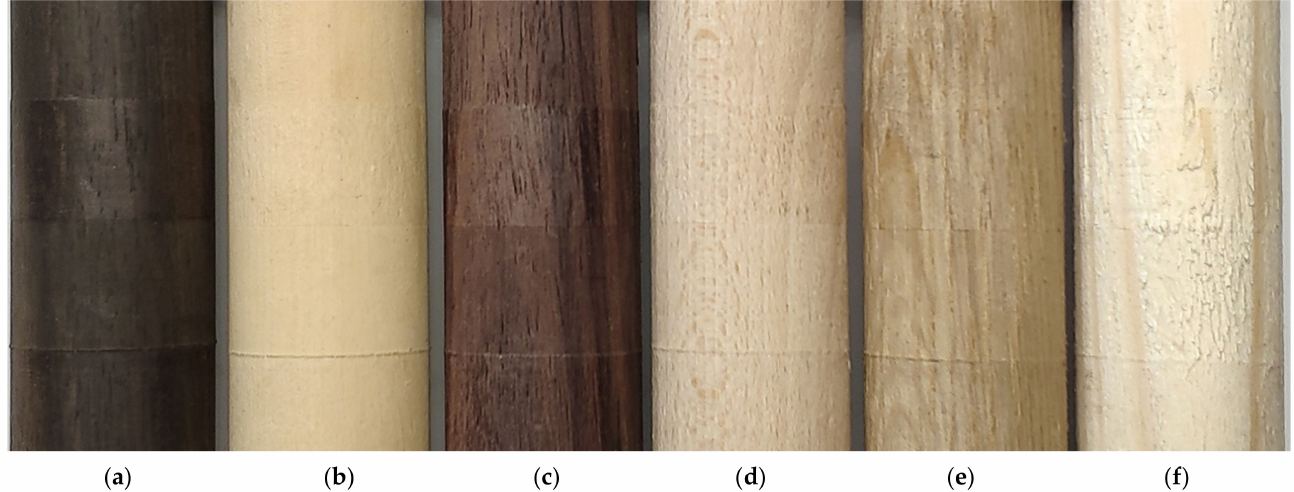
Figure 1. The wood specimens used in the tests ( a ) West African Ebony, Diospyros crassiflora (EB); ( b ) San Domingo Boxwood, Phyllostylon brasiliense (BoW); ( c ) Rio Rosewood, Dalbergia nigra (RW) ( d ) Beechwood, Fagus sylvatica (BeW); ( e ) Oakwood, Quercus robur (OW); ( f ) Pinewood, Pinus silvestris